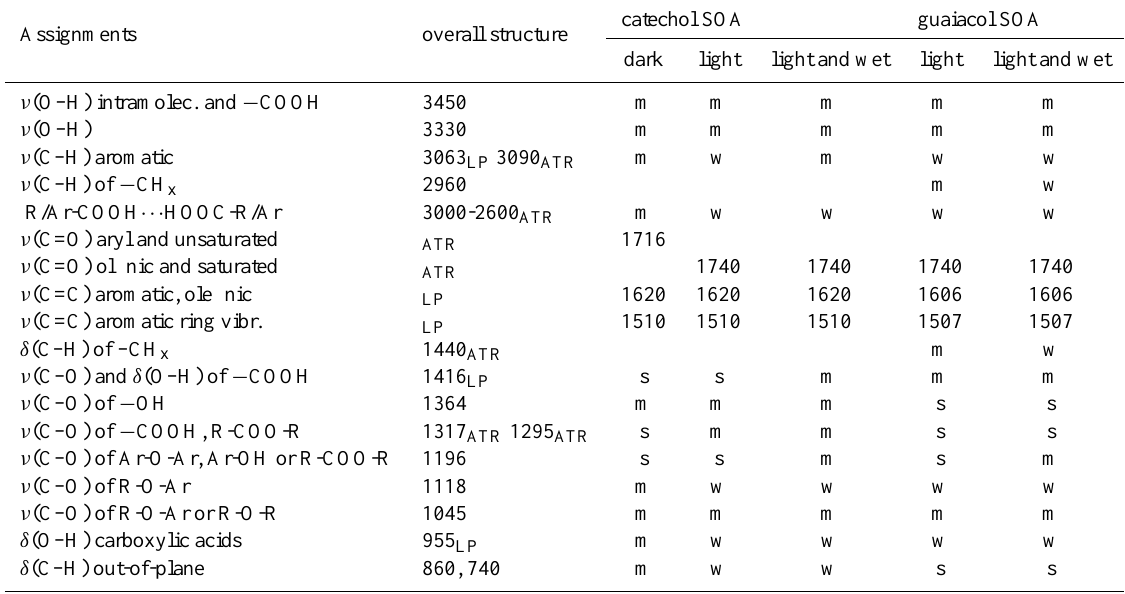
Table 1. Main infrared group-frequencies [cm − 1 ] assigned to functional groups ∗ and structural features observed in SOA from catechol and guaiacol at different ambient conditions by comparing aerosol-smog-chamber long-path FTIR spectra (LP) with ATR spectra (ATR). (w = weak, m = medium, s = strong) Assignments